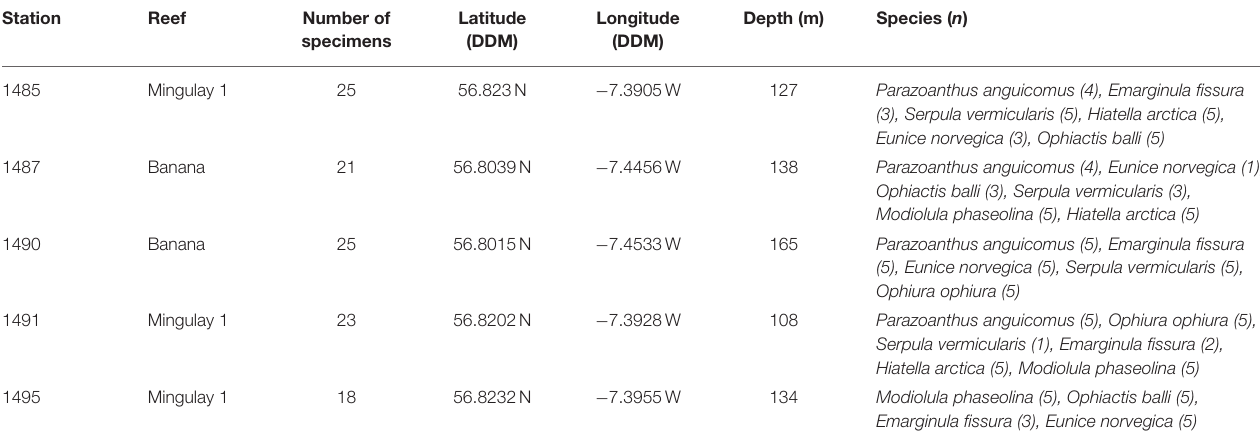
TABLE 2 | Video grab stations and selected species for the assessment of microparticles at the East Mingulay MPA where n equals the amounts of specimens dissected.